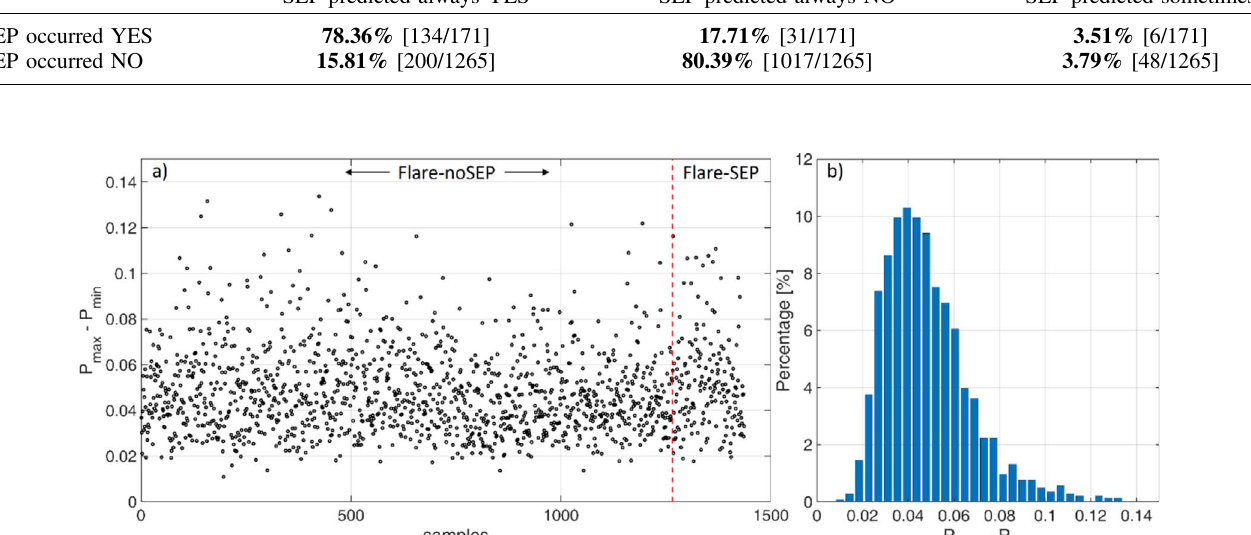
Fig. 6. Maximum probability minus minimum probability of the model from the k = 10 repetitions for each sample. (a) Values for all 1436 Flare-noSEP and Flare-SEP samples; (b) Distribution of values from (a) showing the majority clustered in the [0.02 – 0.08] range.